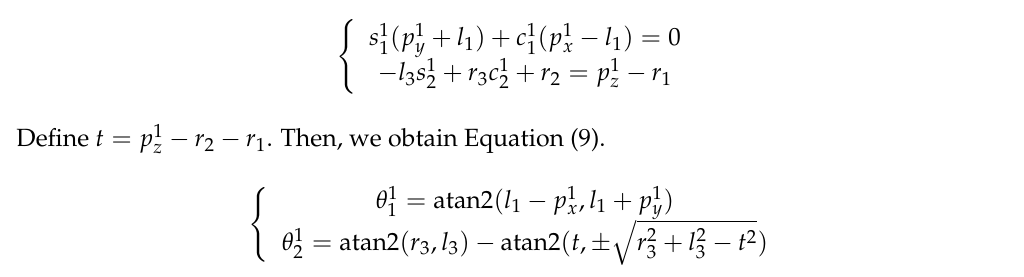
factor was 50%. Thus, like the turtle, the robot can turn left and right.